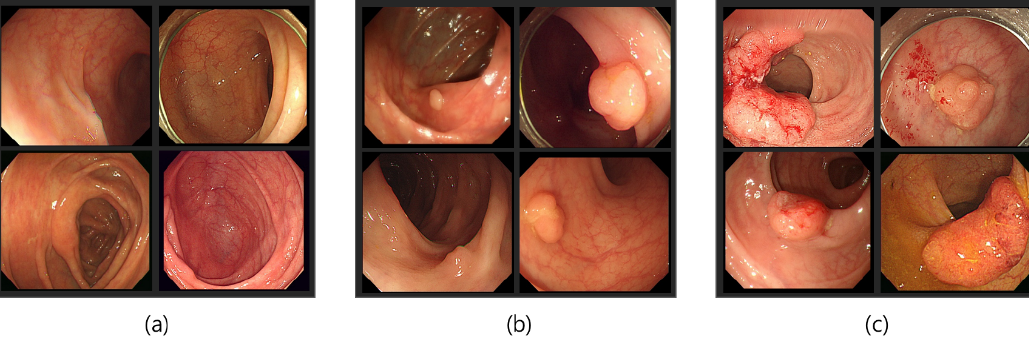
Figure 7. Endoscopy image type in this experiment. ( a ) Normal images; ( b ) adenoma images; ( c ) adenocarcinoma images.